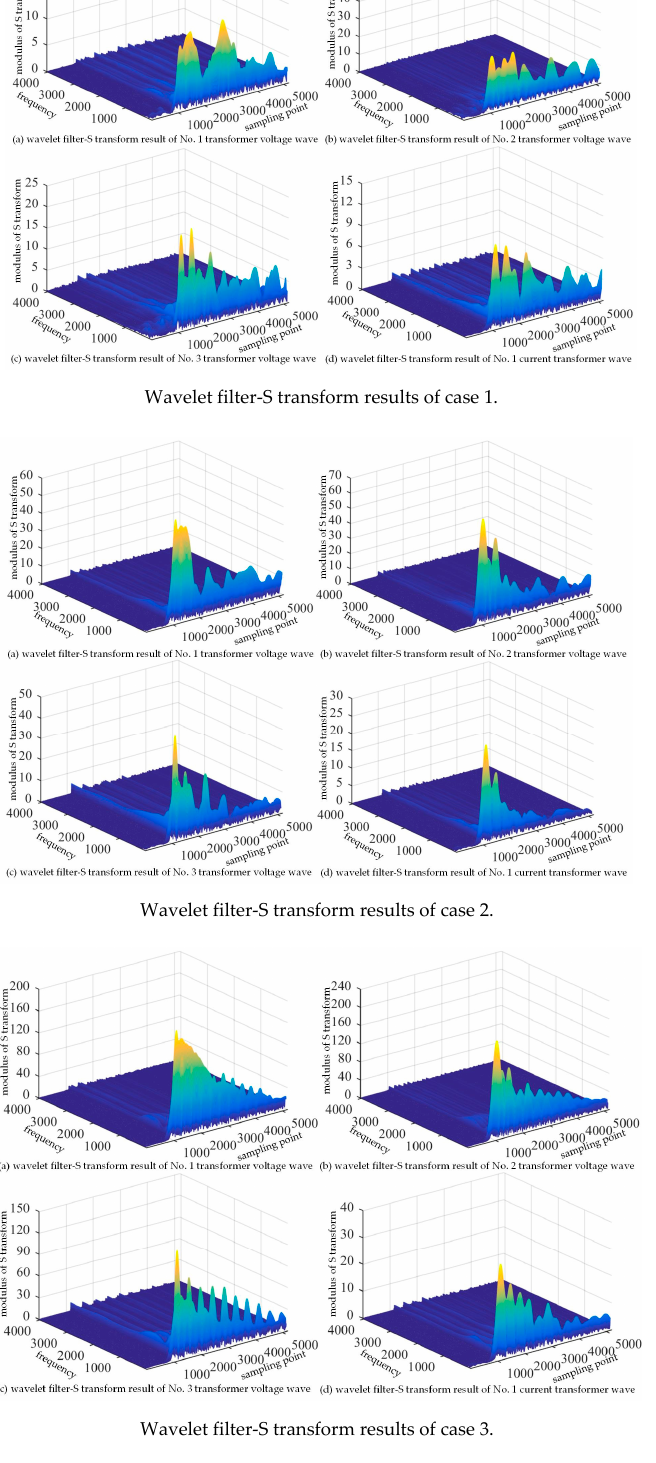
Figure 10. Wavelet filter-S transform results in different conditions.